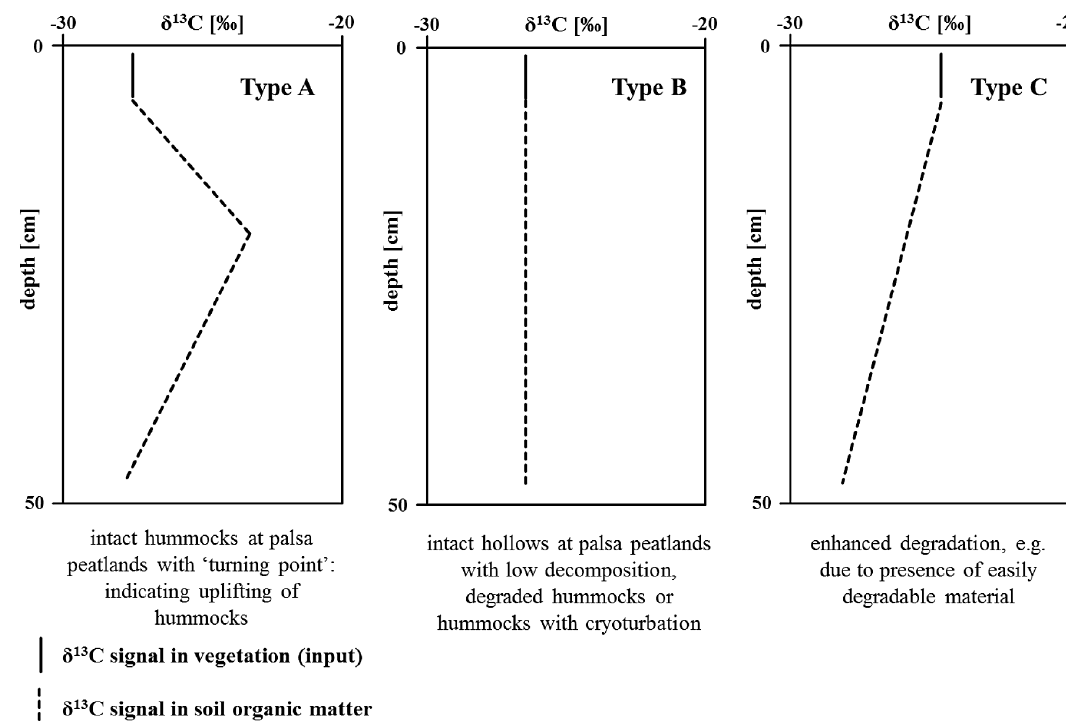
Figure 1. Theoretical concept depth profiles of 13 C in peatland soils with hummocks (type A), degraded hummocks (type B), hollows (type B) and degraded hollows (type C) (modified from Alewell et al.,